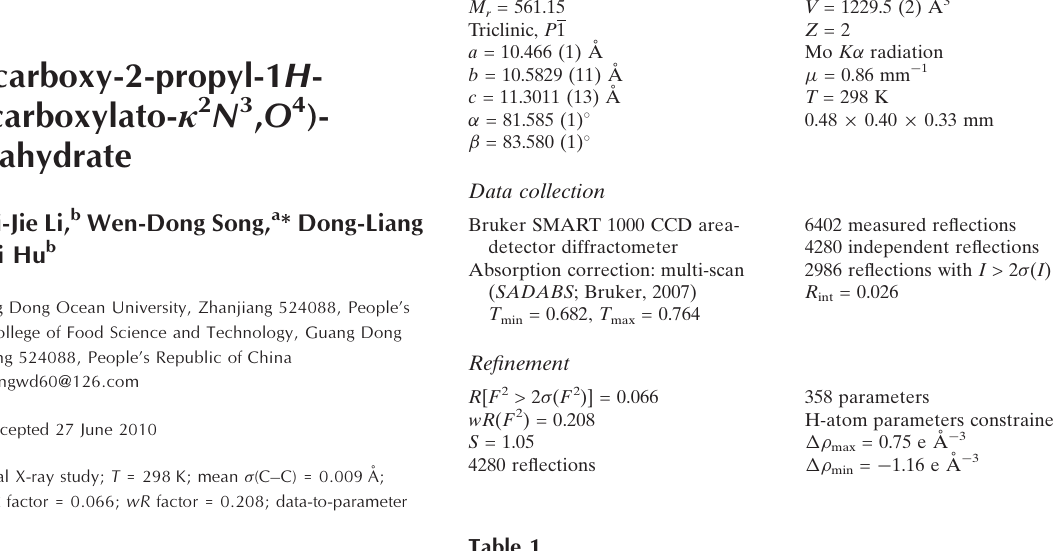
Hydrogen-bond geometry (A˚ , (cid:3)